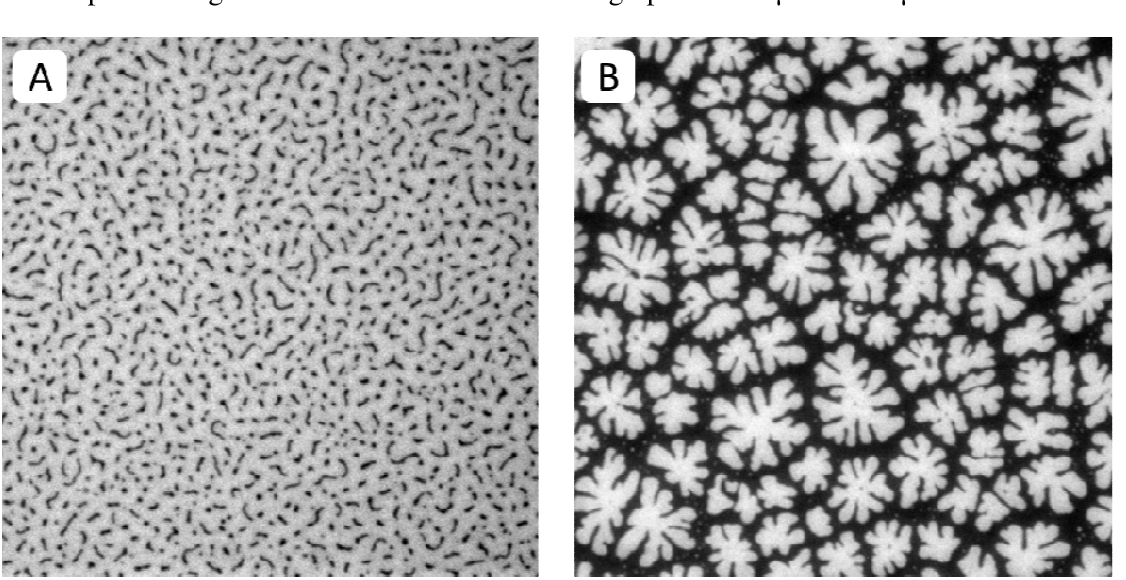
Figure 2. EPI micrographs of physisorbed polymer and 40 mol % DSPE-PEG5000 ( 1.6× Optovar magnification.